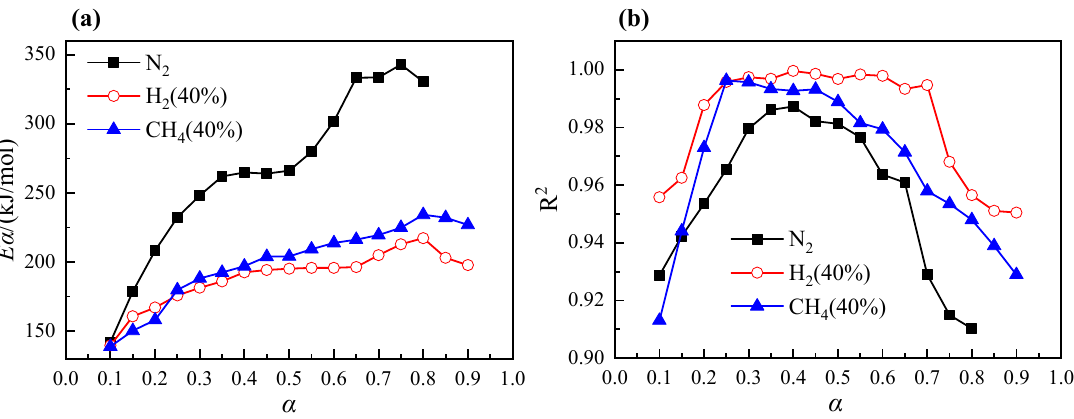
Figure 7. Activation energy, E α , and different conversion rates, α , relationship curve: ( a ) The change curve of E α and; ( b ) The change curve of R 2 .